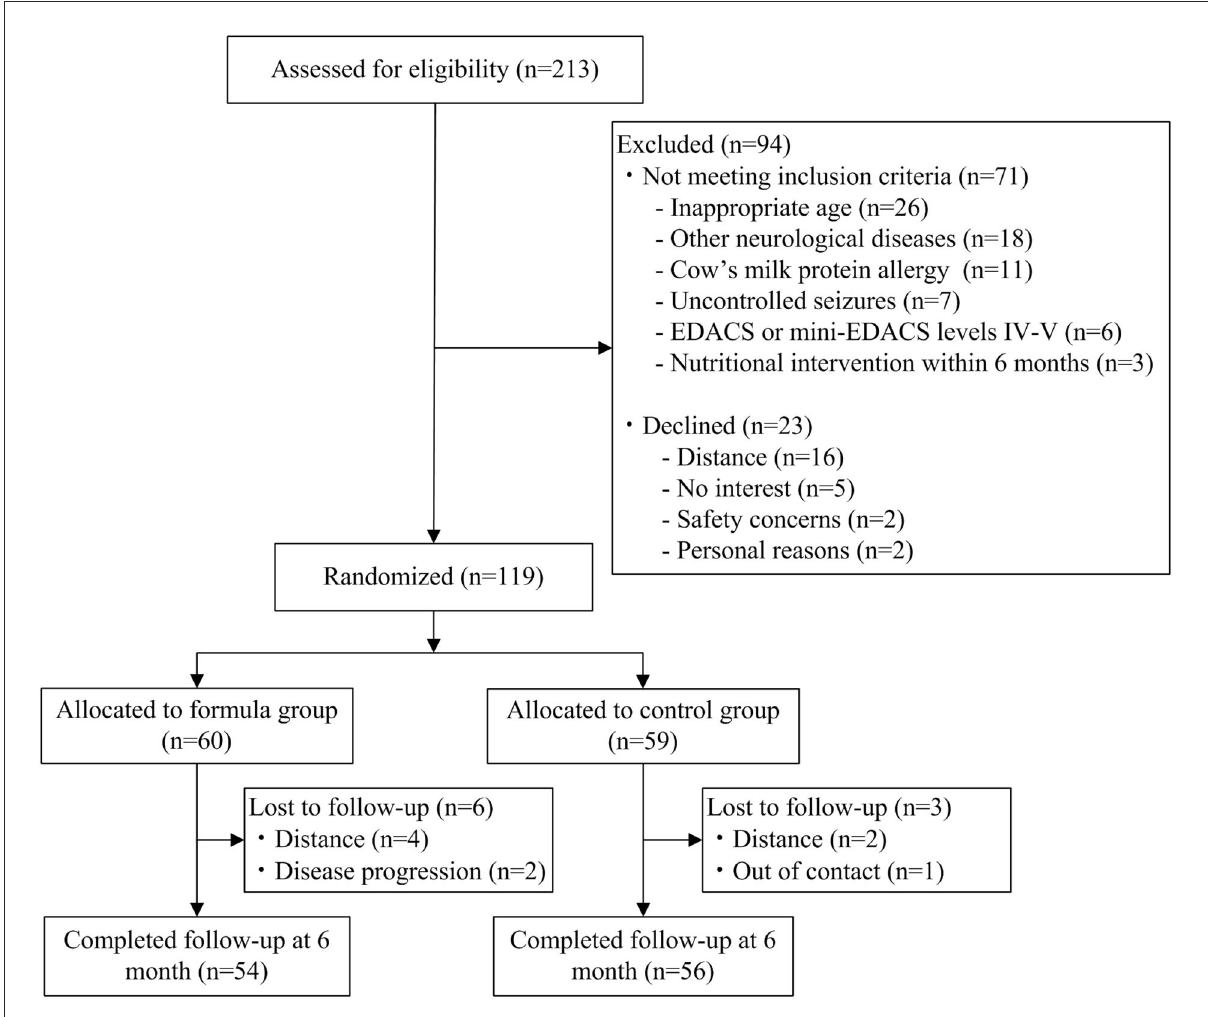
FIGURE1 Consolidated standards of reporting trials